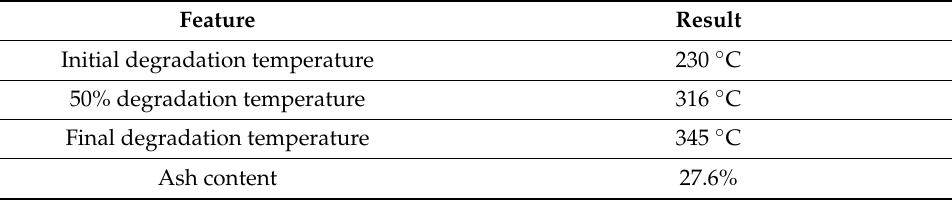
Table 1. TGA results of rice husk pore